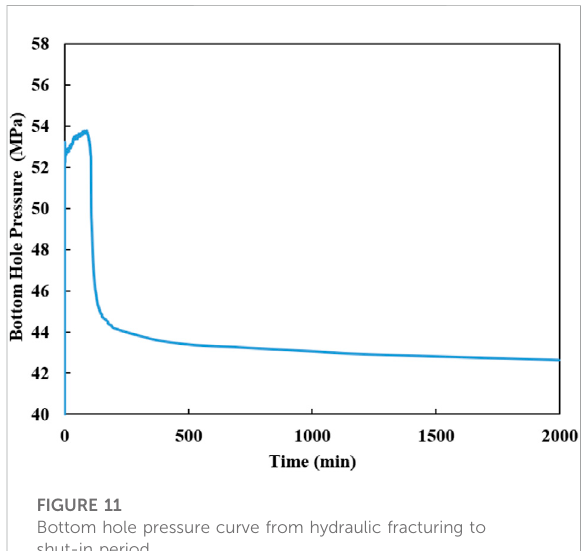
FIGURE 11 Bottom hole pressure curve from hydraulic fracturing to shut-in period.